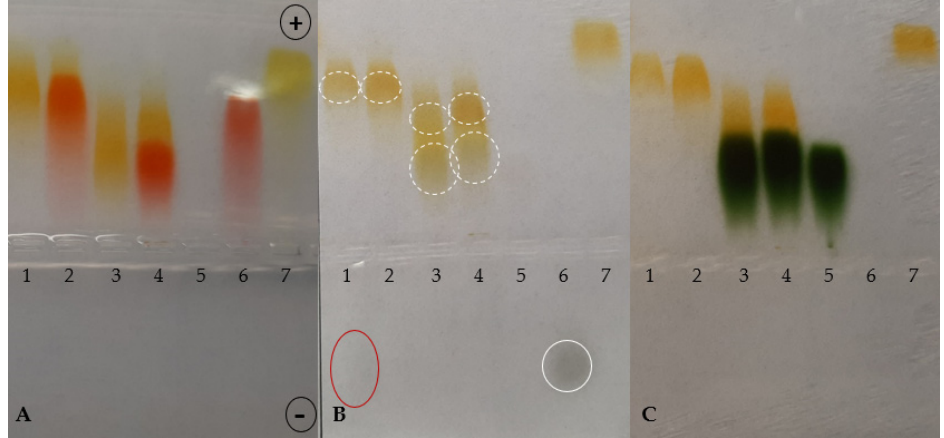
Figure 2. Agarose gel electrophoresis at pH 8.6 of TY, CR, Ag + , BSA and their combinations in different complexes (BSA-TY molar ratio was 1:10 and TY-Ag molar ratio was 1:0.8). ( A ): gel after electrophoresis in barbital buffer; ( B ): reduction with sodium dithionite locating the presence of excess silver; ( C ): bromophenol blue-stained albumin; BSA free and in the complexes with CR, TY or TY-Ag and CR-TY-Ag seen as migrating towards the anode; free Ag + seen as migrating towards the cathode: ( 1 ) TY-Ag (1:0.8); ( 2 ) CR-TY-Ag (TY-Ag = 1: 0.8); ( 3 ) BSA-TY-Ag (BSA-TY = 1:10, TY-Ag = 1:0.8); ( 4 ) BSA-CR-TY-Ag (BSA-CR = 1:10, BSA-TY = 1:10, TY-Ag = 1:0.8); ( 5 ) BSA; ( 6 ) CR-Ag; ( 7 ) TY; a continuous line marks free silver moving towards the cathode, while the dashed line marks complexed silver.